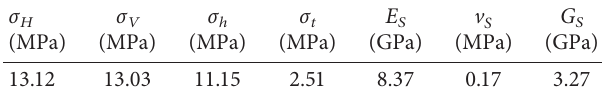
Table 9: Model parameters.